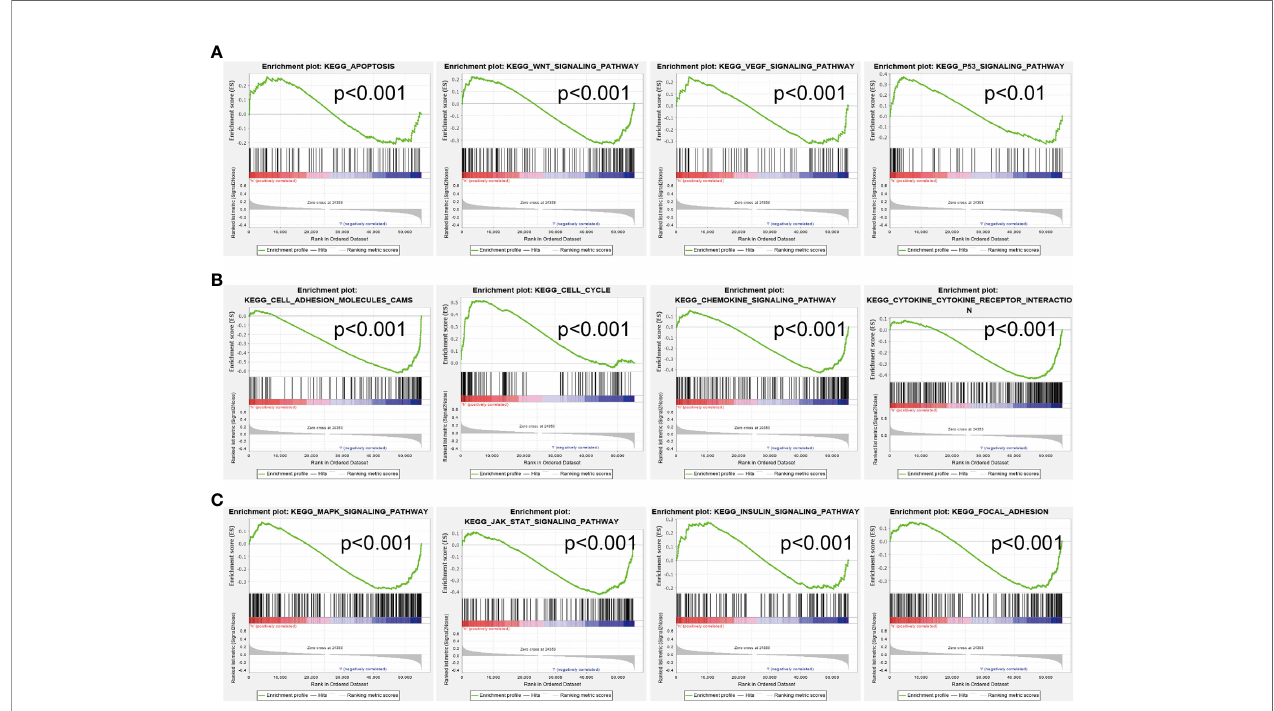
FIGURE 7 | Identi fi cation of AC068228.1-related signaling pathways in lung adenocarcinoma. (A – C) Top 12 signi fi cant KEGG pathways associated with AC068228.1 examined by GSEA software.